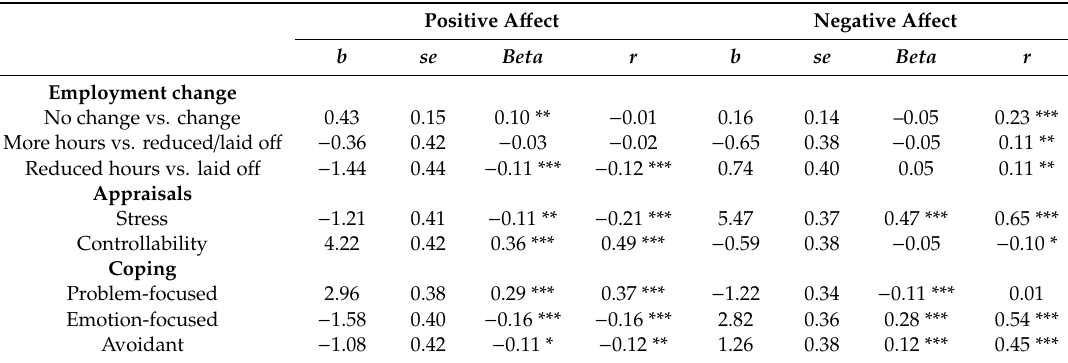
Table 4. Regression coe ffi cients predicting positive and negative a ff ect based on final step